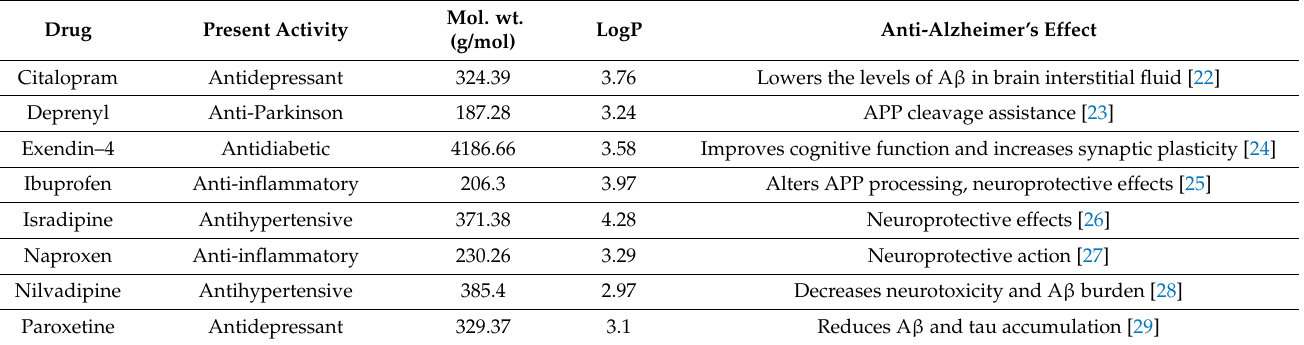
Table 1. Repurposed drugs with their established activity, showing anti-AD